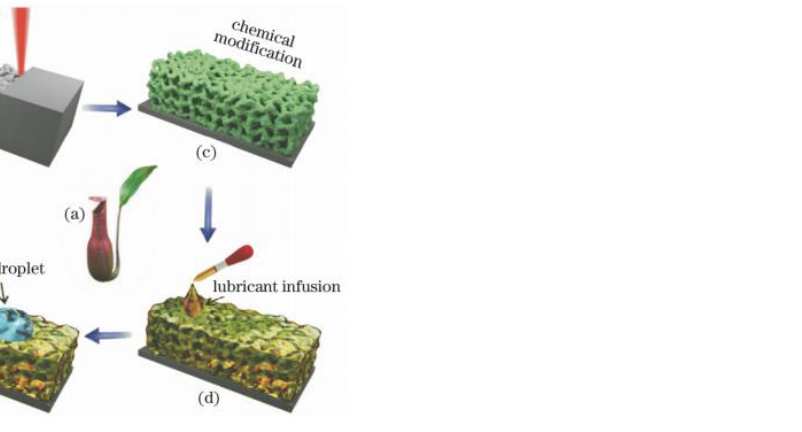
Figure 10. Preparation of a slippery surface of bionic pitcher. ( a ) Photo of the Nepenthes pitcher plant. ( b ) Femtosecond laser ablation used to generate interconnected porous microstructures. ( c ) Fluoroalkylsilane modification used to lower the surface free energy. Green color denotes the fluorosilane molecular layer. ( d ) Infusion of the lubricating liquid (silicone oil) into the laser-induced micropores. ( e ) Foreign liquid droplet sliding down the as prepared slippery surface. (Reprinted with permission from Ref. [52]. 2018, Yong, J.L.). Table 4. Controllable slippery